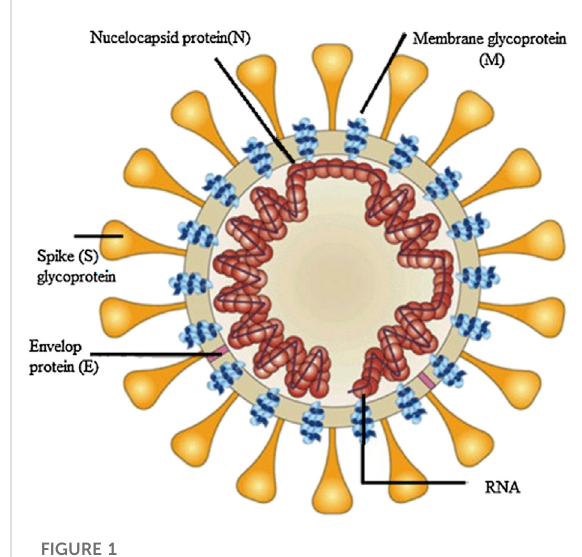
FIGURE 1 Simple Illustration of Coronavirus structure sourced from A reviewonPromisingvaccinedevelopment progress forCOVID-19 disease adapted from (Belete, 2020). Reproduced with permission of Elsevier as this work is part of their open access COVID-19 resource